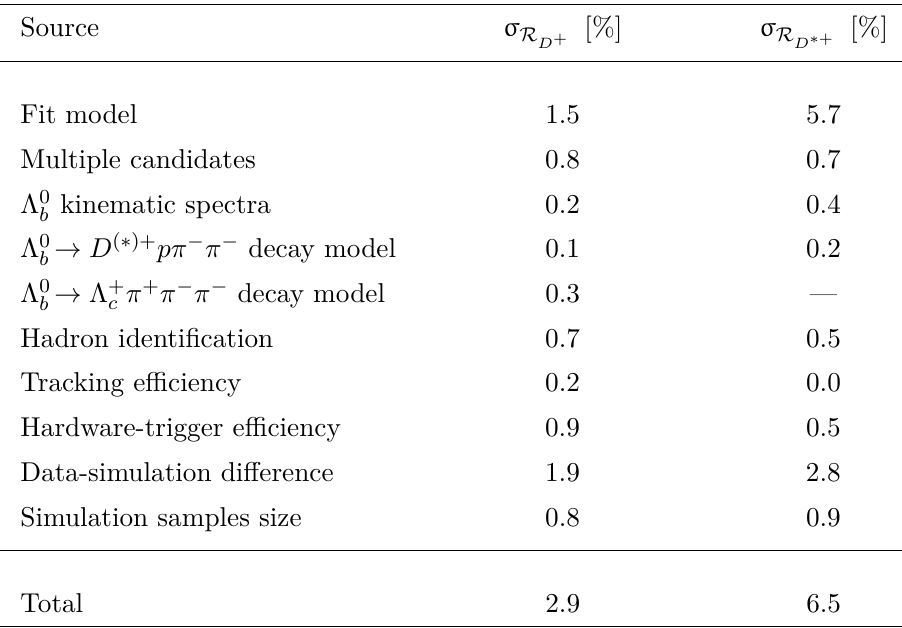
and R . The total uncertainty is D + D ∗ +